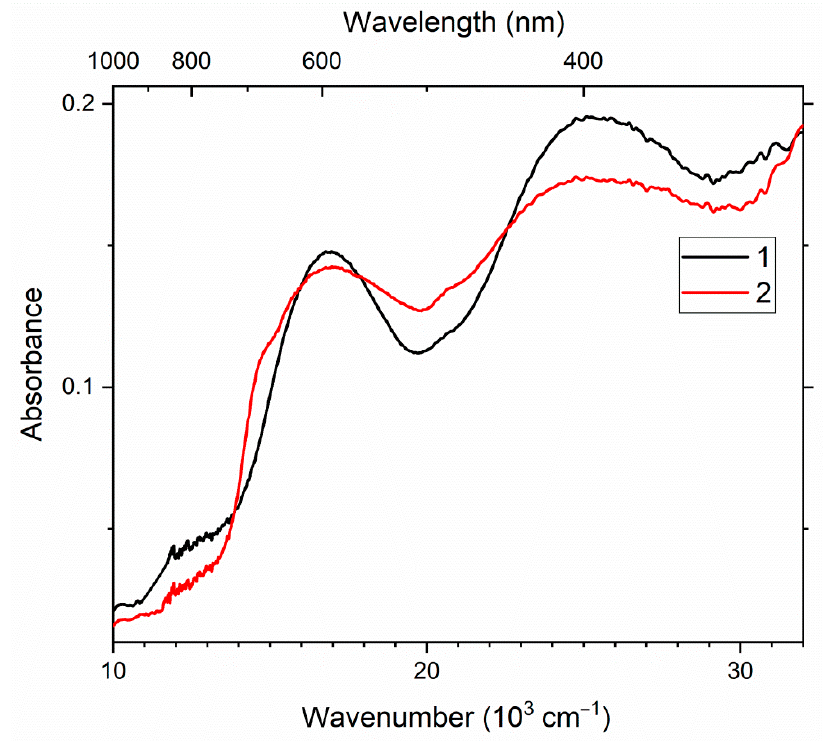
Figure 3. Diffuse transmission spectra of kyanoxalite (Sample 6) before irradiation (curve 1) and after irradiation (curve 2) with light at a wavelength of 240 nm.